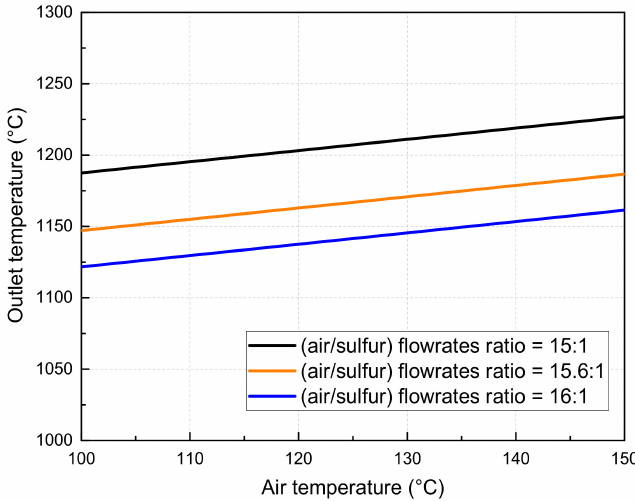
Figure 11. Effect of blown air temperature on the combustion gas